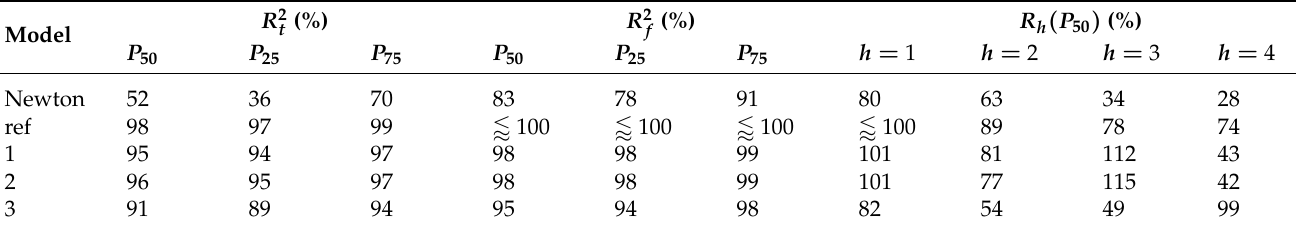
Table 3. The performance of the reconstruction methods.